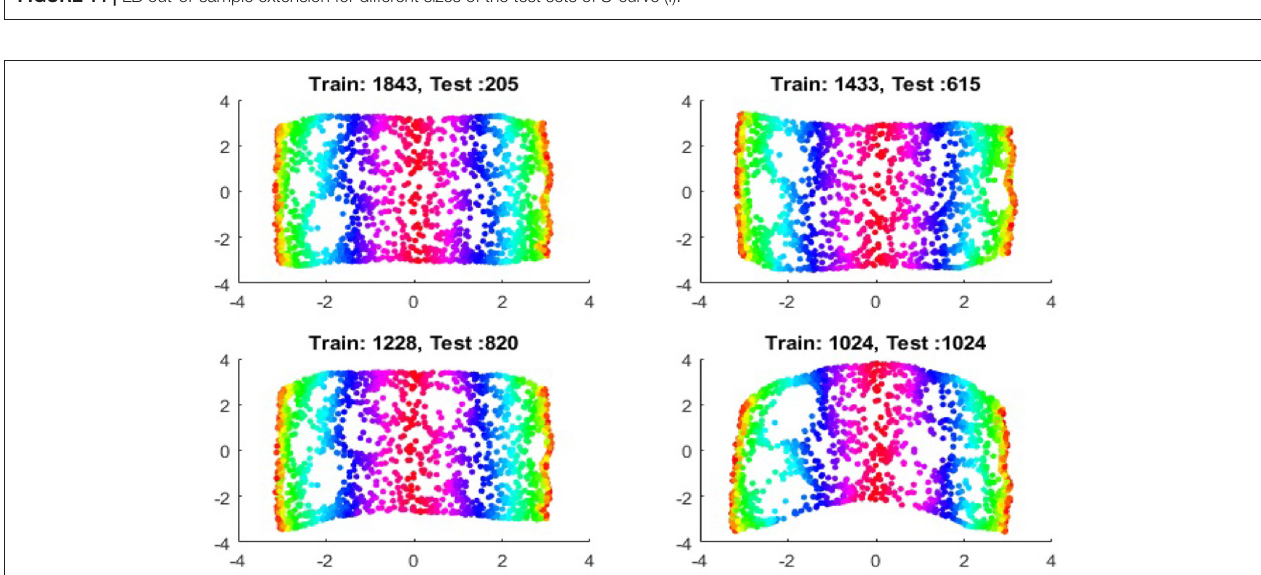
FIGURE 15 | LB out-of-sample extension for different sizes of the test sets of S-curve (II).